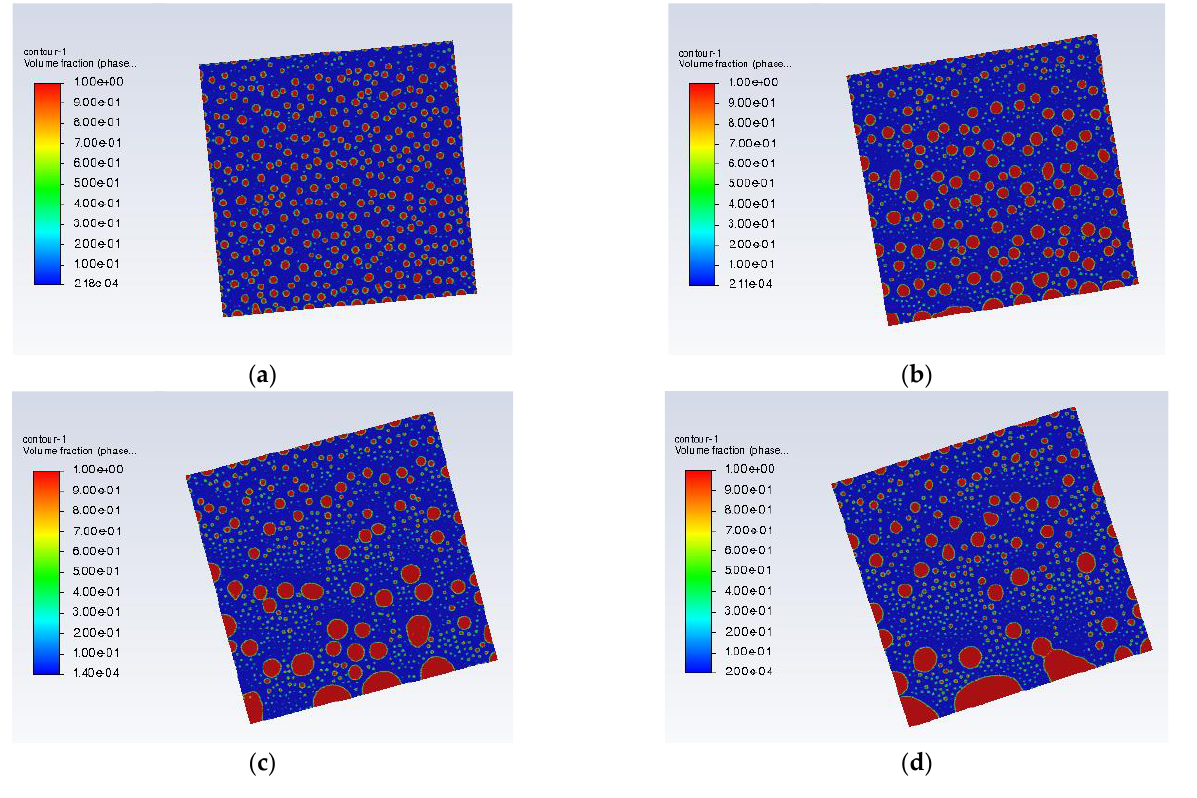
Figure 11. Droplet movement and distribution against time at a rotational angular velocity of 1.57 rad·s −1 and contact angle of 90°: ( a ) 0.2 s; ( b ) 0.3 s; ( c ) 0.4 s; ( d ) 0.5 s. Table 5. Comparison of the equivalent evaporation rates in filmwise condensation at different rotational angular